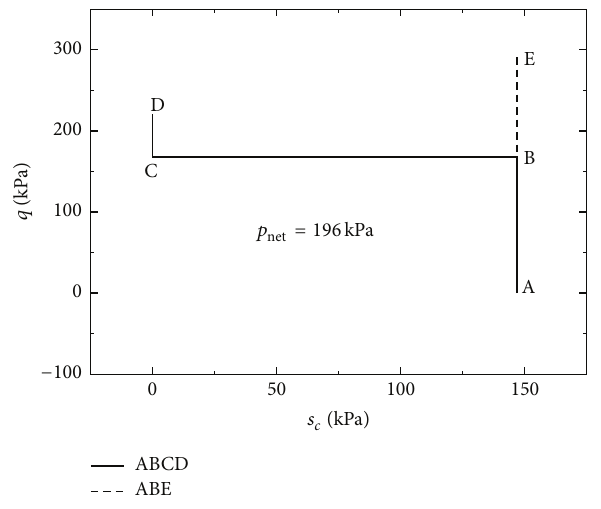
Figure 8: Stress paths used in the triaxial tests.